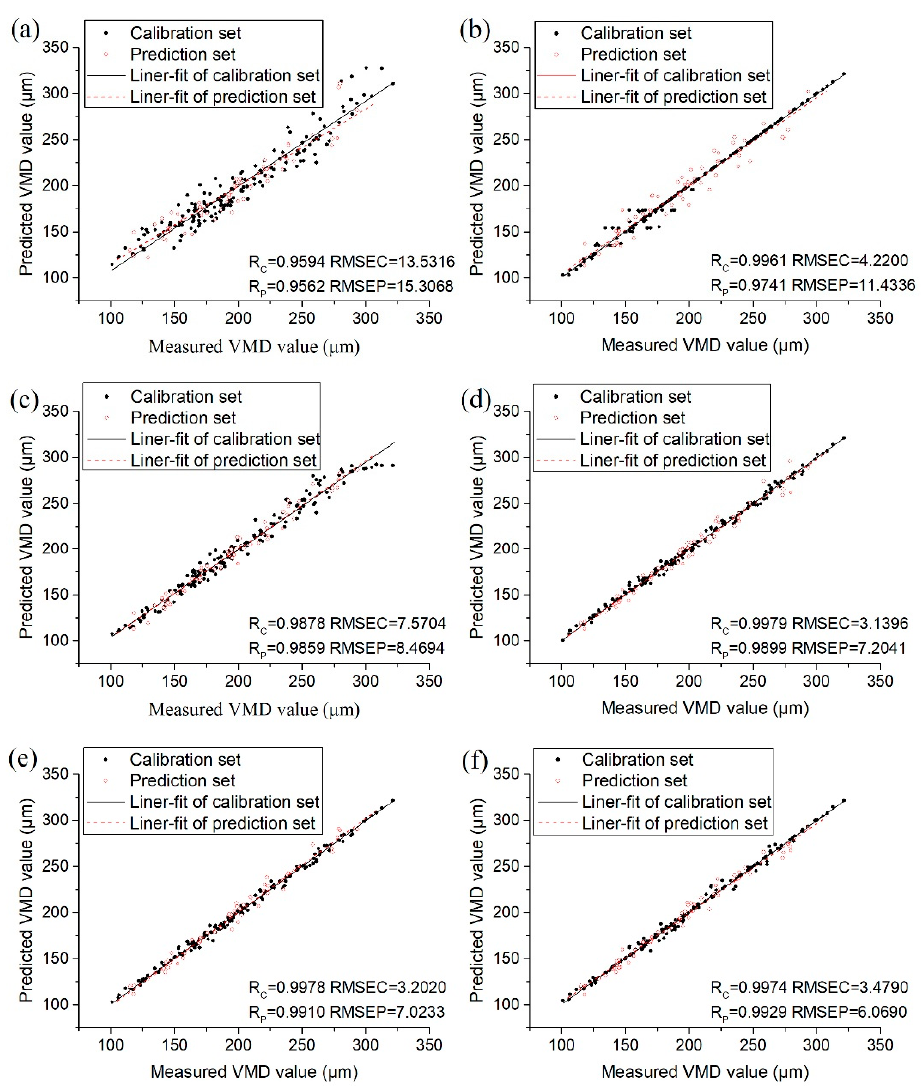
Figure 4. Scatter plot of measured value and predicted value of VMD: ( a ) polynomial regression; ( b ) DT; ( c ) MLP; ( d ) RBFNN; ( e ) ELM; ( f ) SVR. Table 8. Model parameters of different models in predicting